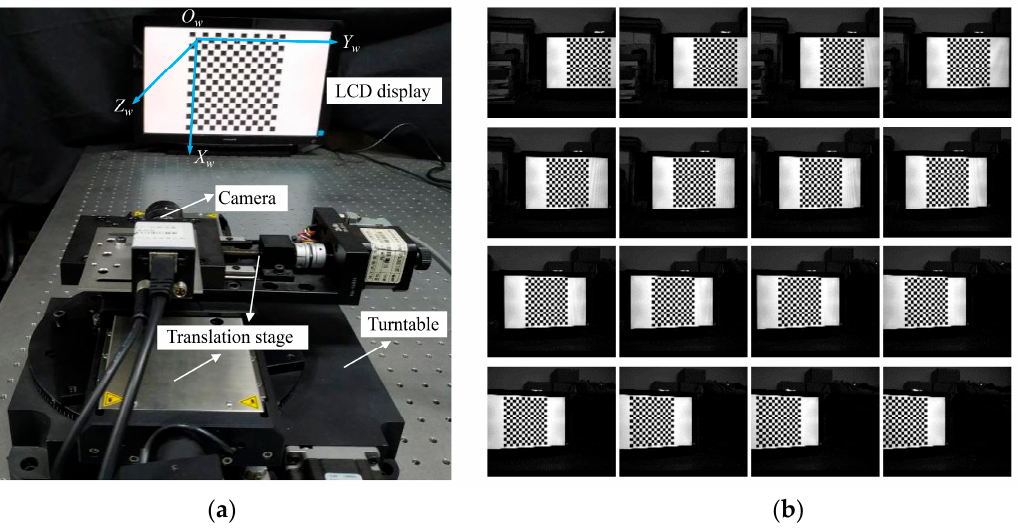
Figure 8. ( a ) Experimental setup; ( b ) one set of the patterns for calibration.